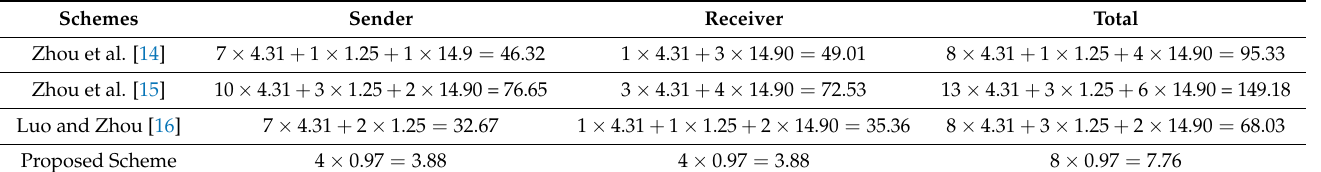
Table 3. Comparison of computation cost (in ms).